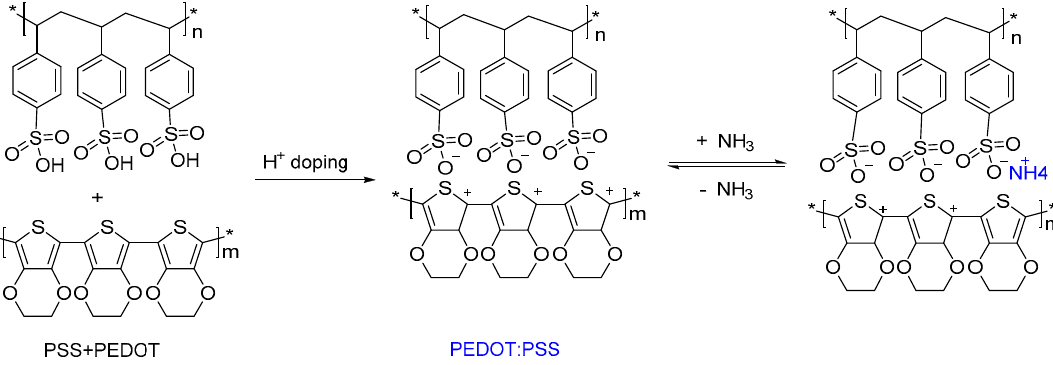
Figure 7. Diagram of the reaction mechanism of PEDOT:PSS and ammonia gas.